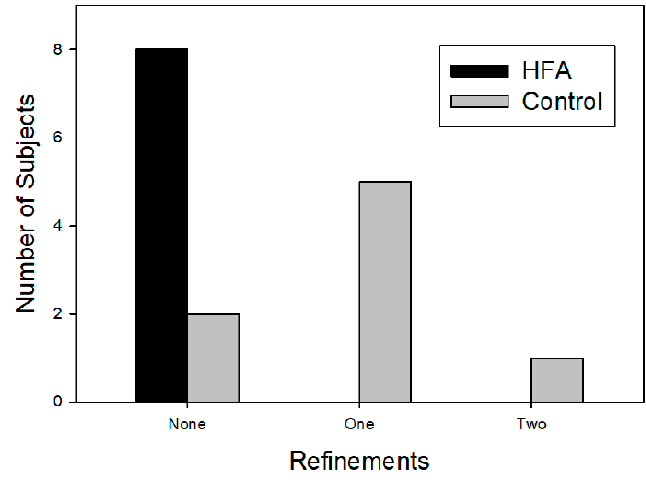
Figure 3. Incidence and number of subjects requiring refinement.